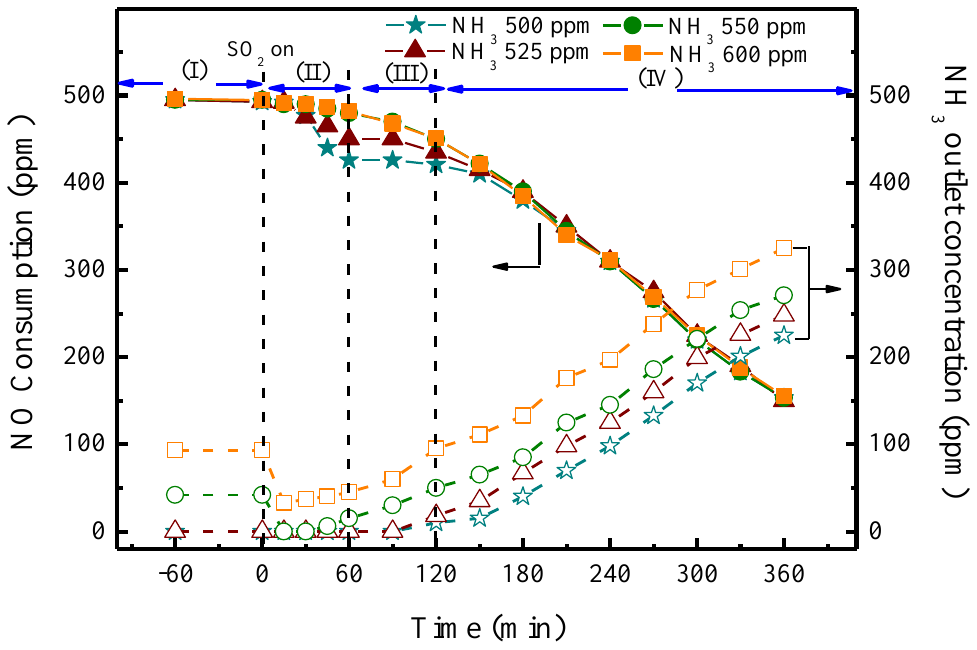
Figure 6. NO consumption and outlet NH 3 concentrations in the NH 3 -SCR reaction with SO 2 over MnFe/TiO 2 catalyst at different ammonium amounts. Reaction conditions: Reaction temperature = 150 °C, [NO] = 500 ppm, [NH 3 ] = 500~650 ppm, [SO 2 ] = 150 ppm, [O 2 ] = 10%, balanced with N 2 , and GHSV = 50,000 h −1 .